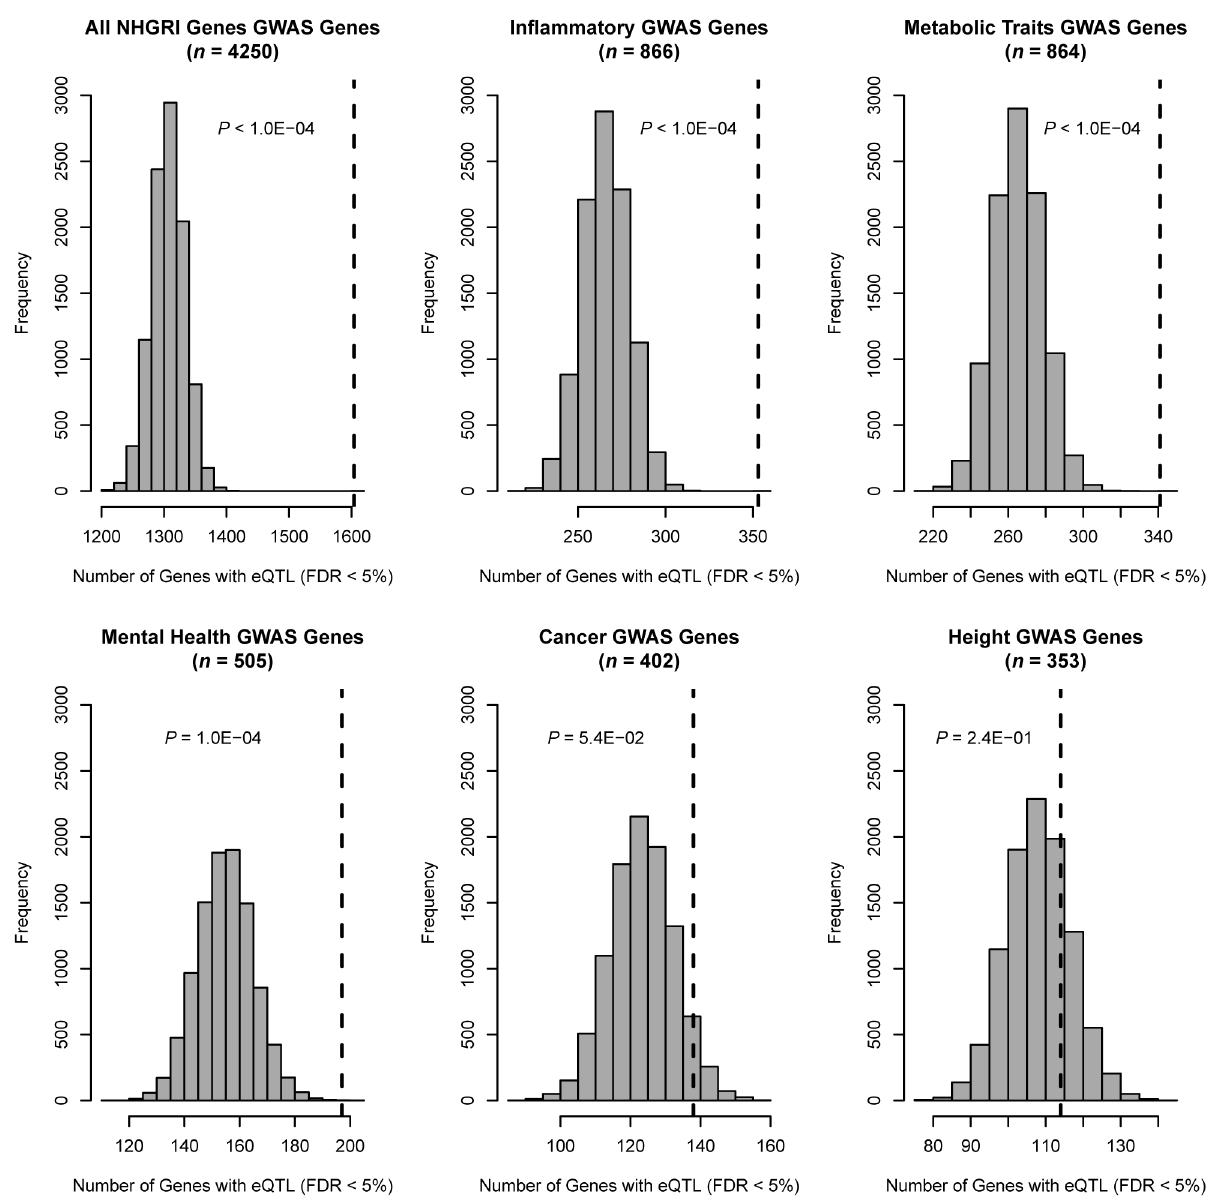
Fig 3. Genes associated with inflammatory and other categories of disease traits enriched for meta-analysis eQTL genes. In each histogram, the observed number of genes in the given category harboring at least one significant eQTL SNP (meta-analysis FDR < 5%) is marked with a dashed vertical line. The null distributions derived from 10,000 permutations are shown with gray